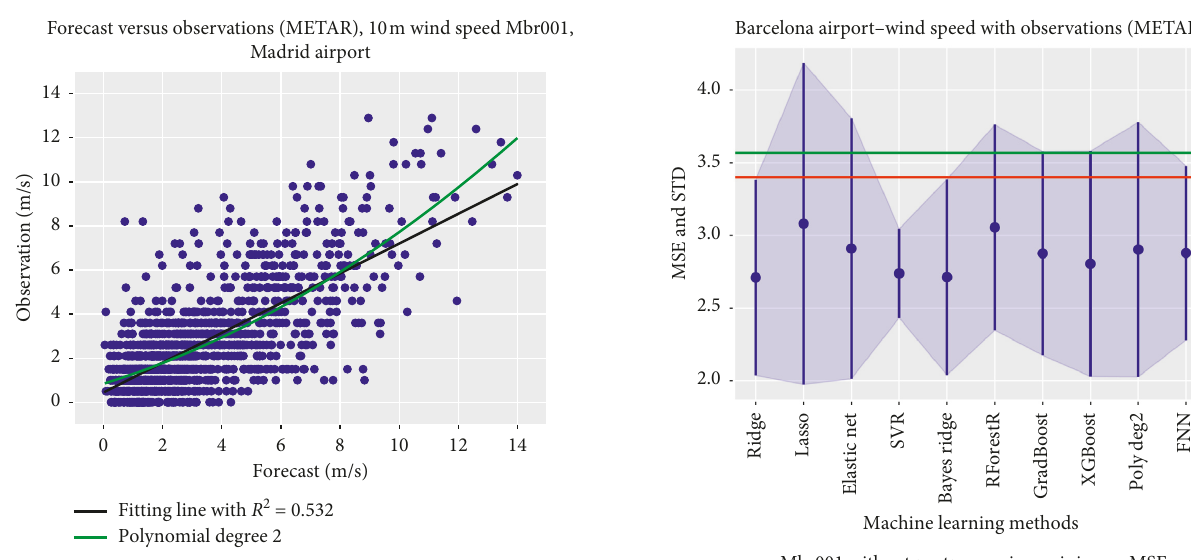
Figure 11: 10meters total wind scatter plot for Madrid airport, LAM-EPS AEMET- c SREPS member 001: HARMONIE-AROME with LBC from ECMWF/IFS.